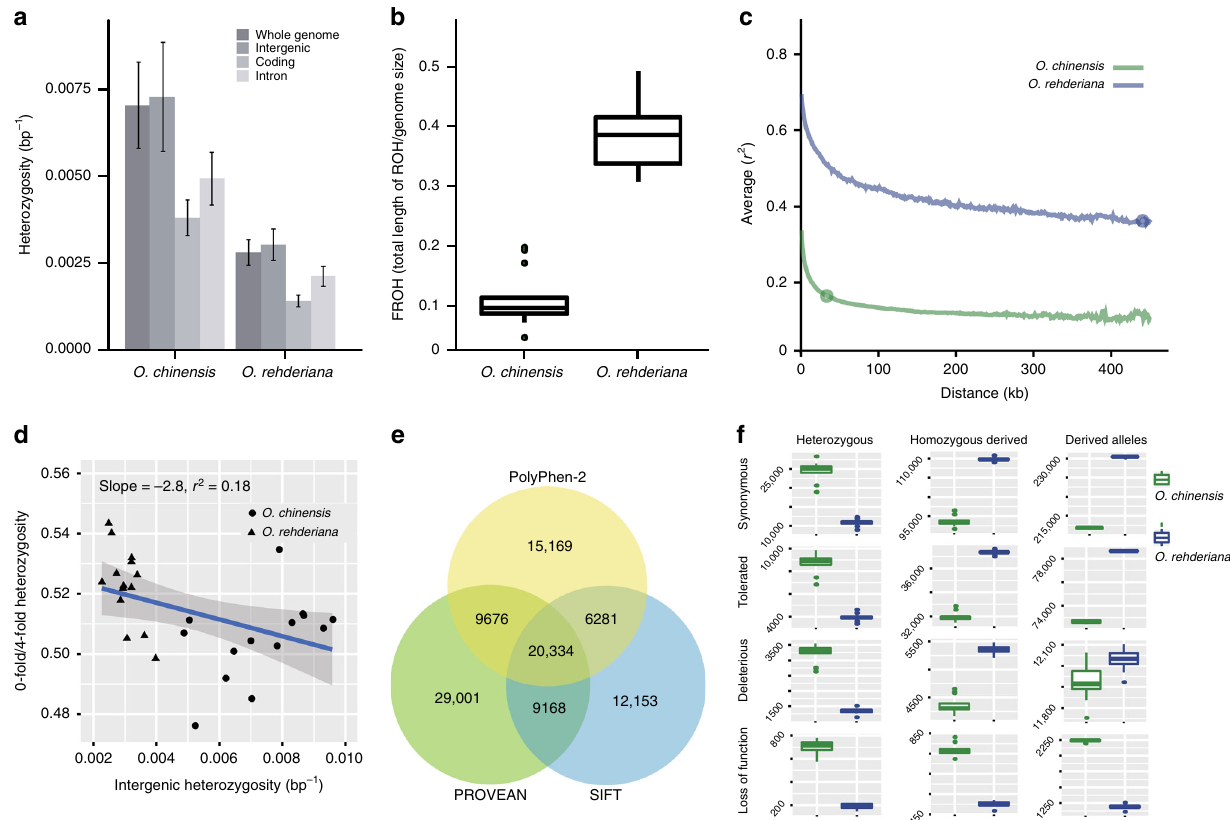
Fig. 4 Diversity, linkage disequilibrium, and genetic load metrics for O. rehderiana and O. chinensis . a Bar chart of heterozygosity of the whole genome and intergenic, intron, and coding regions for each individual in the two species. Error bars represent two-fold standard deviations. b Box plot of FROH for each individual in the two species. The line in the center of the box represent the median values, the edges of the box represent the fi rst and third quartiles, and the whiskers above and below the box show the range of values. c Linkage disequilibrium (LD) decay of the O. rehderiana (Ore01 – Ore04) and O. chinensis (Och01 – Och14) genomes. Open circles denote distances where the r 2 correlation coef fi cient reduces to half of its maximum (~444 kb for O. rehderiana and ~29 kb for O. chinensis ). d The negative relationship between neutral (intergenic) diversity and the ratio of heterozygosity at zero-fold relative to four-fold sites. The triangle represents O. rehderiana individuals and the square represent O. chinensis individuals. e A Venn diagram of the deleterious variants predicted by PolyPhen-2, PROVEAN, and SIFT. f Comparison of deleterious genetic variation in O. rehderiana and O. chinensis . The total number of derived alleles is based on counting each heterozygous genotype once and each homozygous-derived genotype